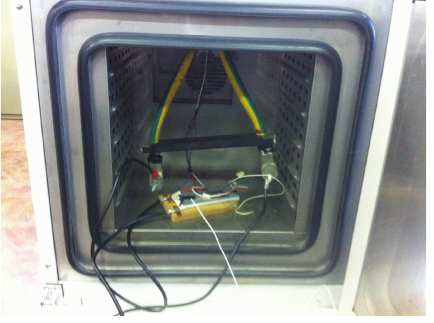
Figure 4: Climatic chamber.